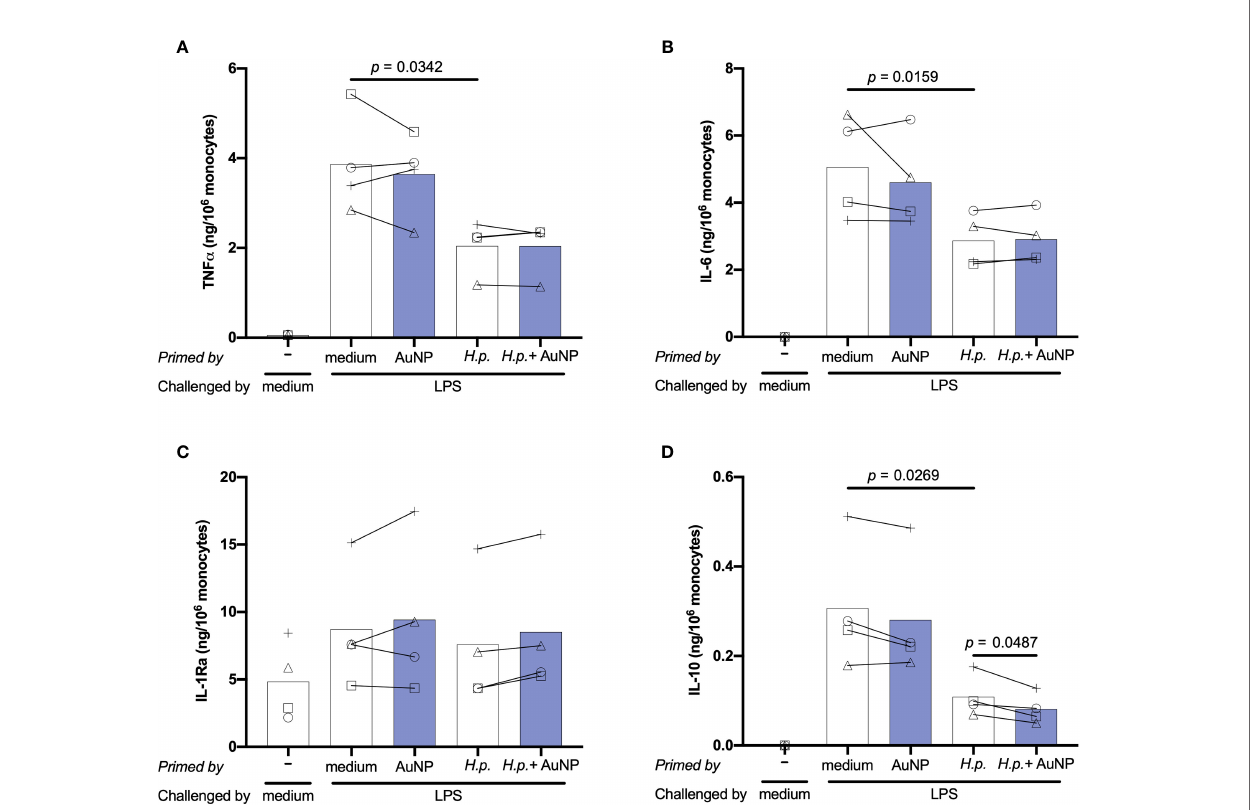
FIGURE 6 | Effect of AuNPs on the memory response of monocytes primed by live ( H ) pylori . CD14 + monocytes were exposed to medium or H. pylori (at MOI 0.2) for 24 h in the presence or absence of AuNPs (20 µg/mL, indicated by blue bars), then washed and rested for 6 days. After resting, cells were challenged with LPS (5 ng/mL) for 24 h, supernatants were collected and examined for the production of TNF a (A) , IL-6 (B) , IL-1Ra (C) and IL-10 (D) . Values from individual donors are depicted concurrent with mean cytokine production. p values are indicated when < 0.05 for the comparisons between unprimed and primed groups and priming with and without NPs, n = 4.